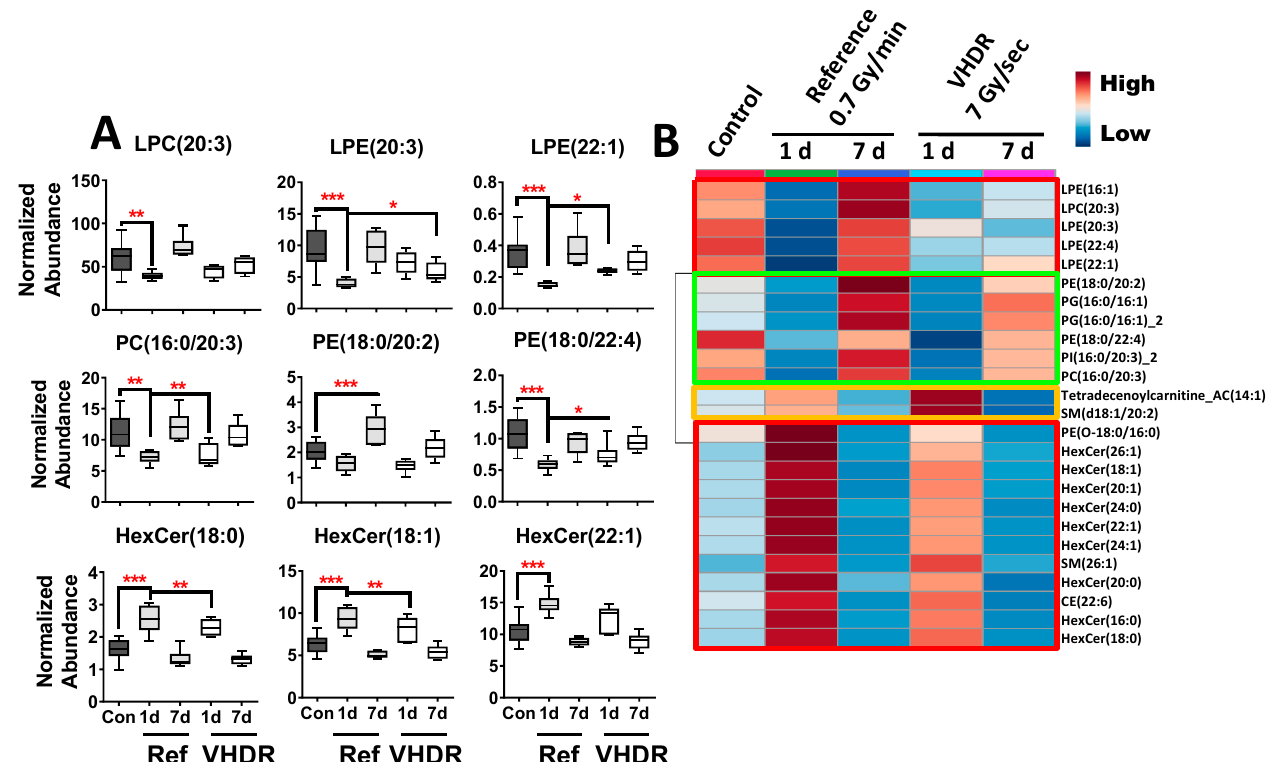
Figure 3. ( A ) Lipid concentrations in mouse serum after exposure to the reference dose rate (0.7 Gy/min) or very high-dose rate (VHDR) (7 Gy/s) at 1 and 7 days (d) identified from the heatmap in panel B. ( B ) A heatmap of the top 25 lipids shows that several lysoglycerophospholipids, glycerophospholipids, and hexosylceramides (red boxes) display similar patterns between dose rates with slightly higher fold changes in the reference dose rate cohort. (* p < 0.05, ** p < 0.01, *** p < 0.001 determined by a one-way ANOVA and a Dunnett’s multiple comparison test with p values corrected for multiple comparisons of post-irradiation samples to the control, Means ± S.E.).